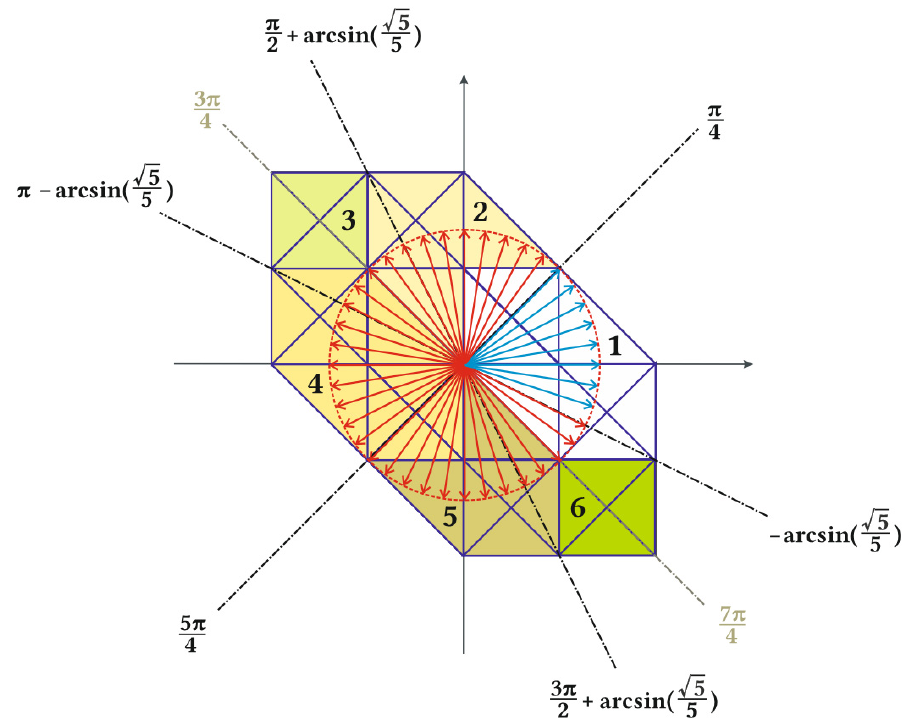
Figure 6. Transposition borders used for transposition of U 0 vector. The red circle marks the limit of maximum modulation. Red and blue denote all discrete positions of U 0 for 50 Hz, full modulation, and T c = 500 µ s. Positions of U 0 marked in blue are transposed to the first outer two-level hexagon. The alternative transposition borders are marked green.